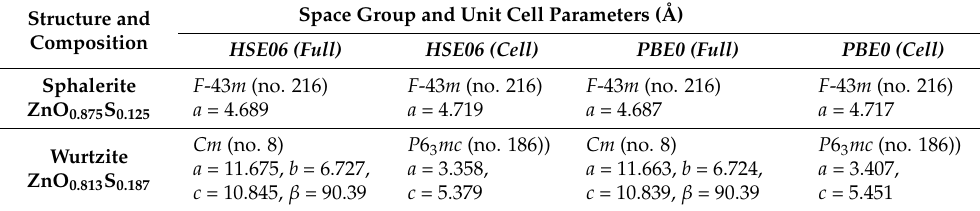
Figure 5. ZnO/ZnS supercell models of ( a ) wurtzite structure with composition ZnO 0.813 S 0.187 ; ( b ) sphalerite structure with composition ZnO 0.875 S 0.125 . Grey, yellow and red spheres correspond to zinc, sulfur, and oxygen atoms, respectively. Table 1. Calculated structural data of the ZnO/ZnS supercell models with various ZnO/ZnS compo- sitions. Cell parameters are given in Angstrom (Å). Local optimizations were performed with the PBE0 and HSE06 hybrid